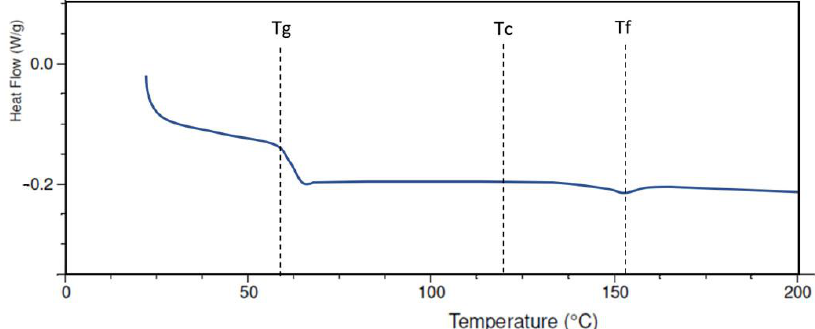
Figure 5. DSC analysis of the